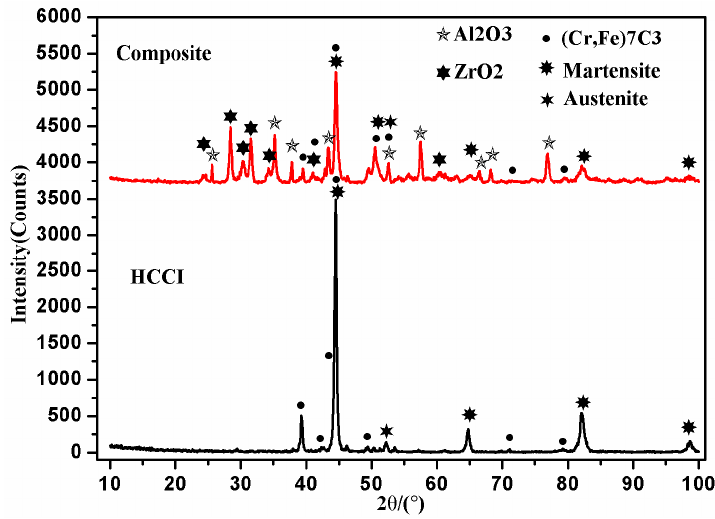
Figure 4. XRD patterns of the composites and the high chromium cast iron (HCCI).